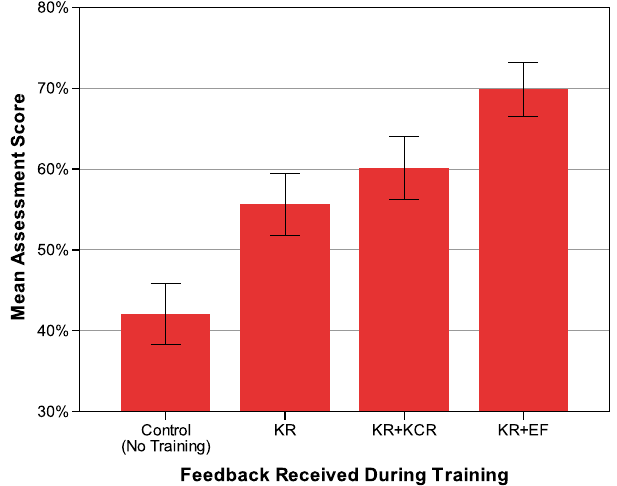
FIG. 3. Experiment 1 mean assessment scores for each